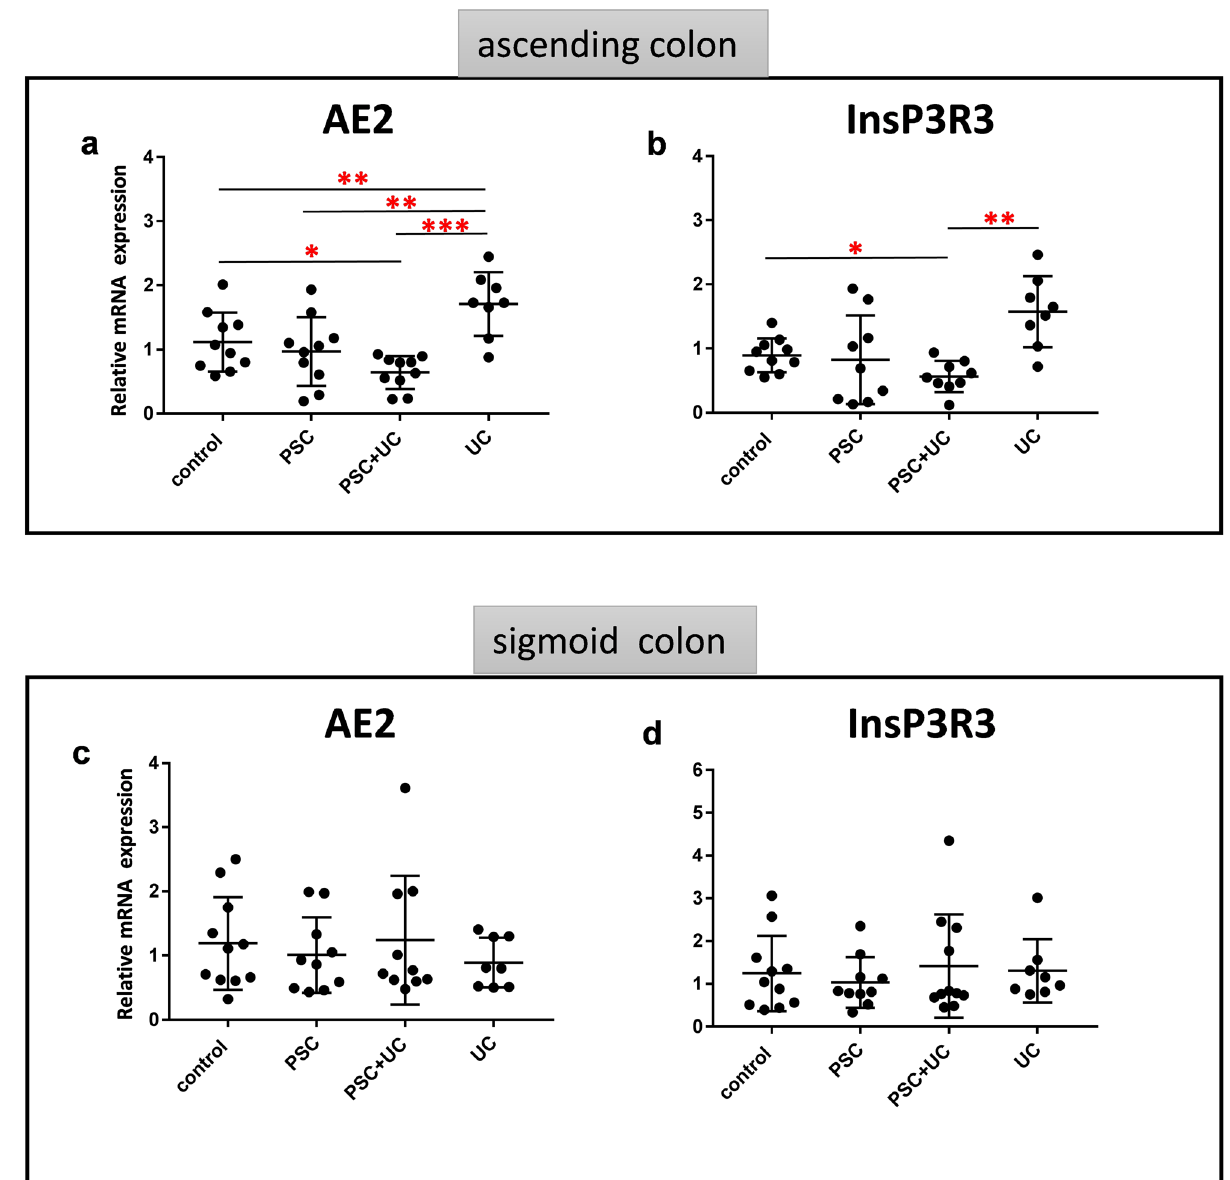
Figure 2. Expression of AE2 and InsP3R3 mRNA in large intestines of the patients. Relative expression levels of anion exchange protein 2 (AE2) (a,c) and inositol-1,4,5-trisphosphate-receptor (InsP3R3) (b,d) in ascending (a,b) and sigmoid colons (c,d) of controls (n = 10), PSC (n = 10), PSC + UC (n = 10), and UC (n = 10). The expression of all genes are normalized to an endogenous reference 18S rRNA and presented as a relative fold change to controls according to the comparative Ct method (2 −ΔΔCt ). Dots illustrate each patient and lines the mean plus interquartile range (IQR).Statistics: one-way ANOVA followed by Fisher’s PLSD test within the groups; *indicates p-value < 0.05, ** p-value p < 0.01, *** p-value <